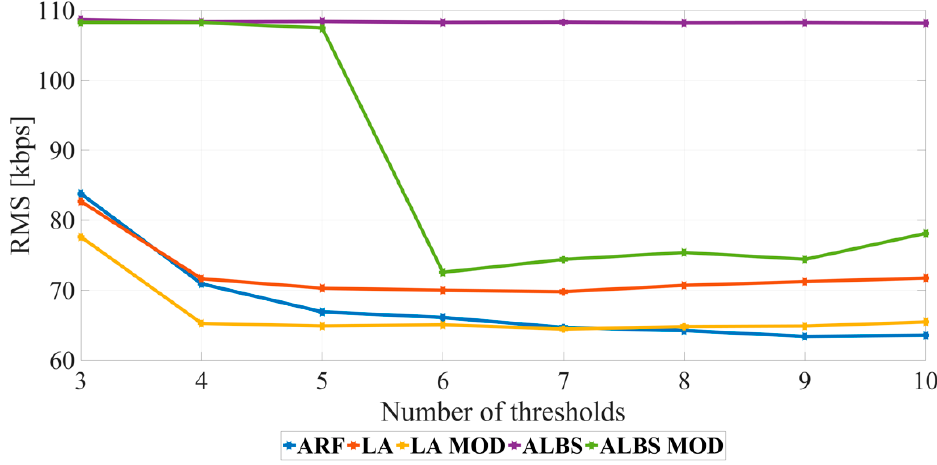
Figure 7. Results of the analyzed methods’ effectiveness as a function of the deterministic number of the bitrate threshold values for the NB interface. Table 4. The chosen parameters of the WBAN heterogeneous simulator.